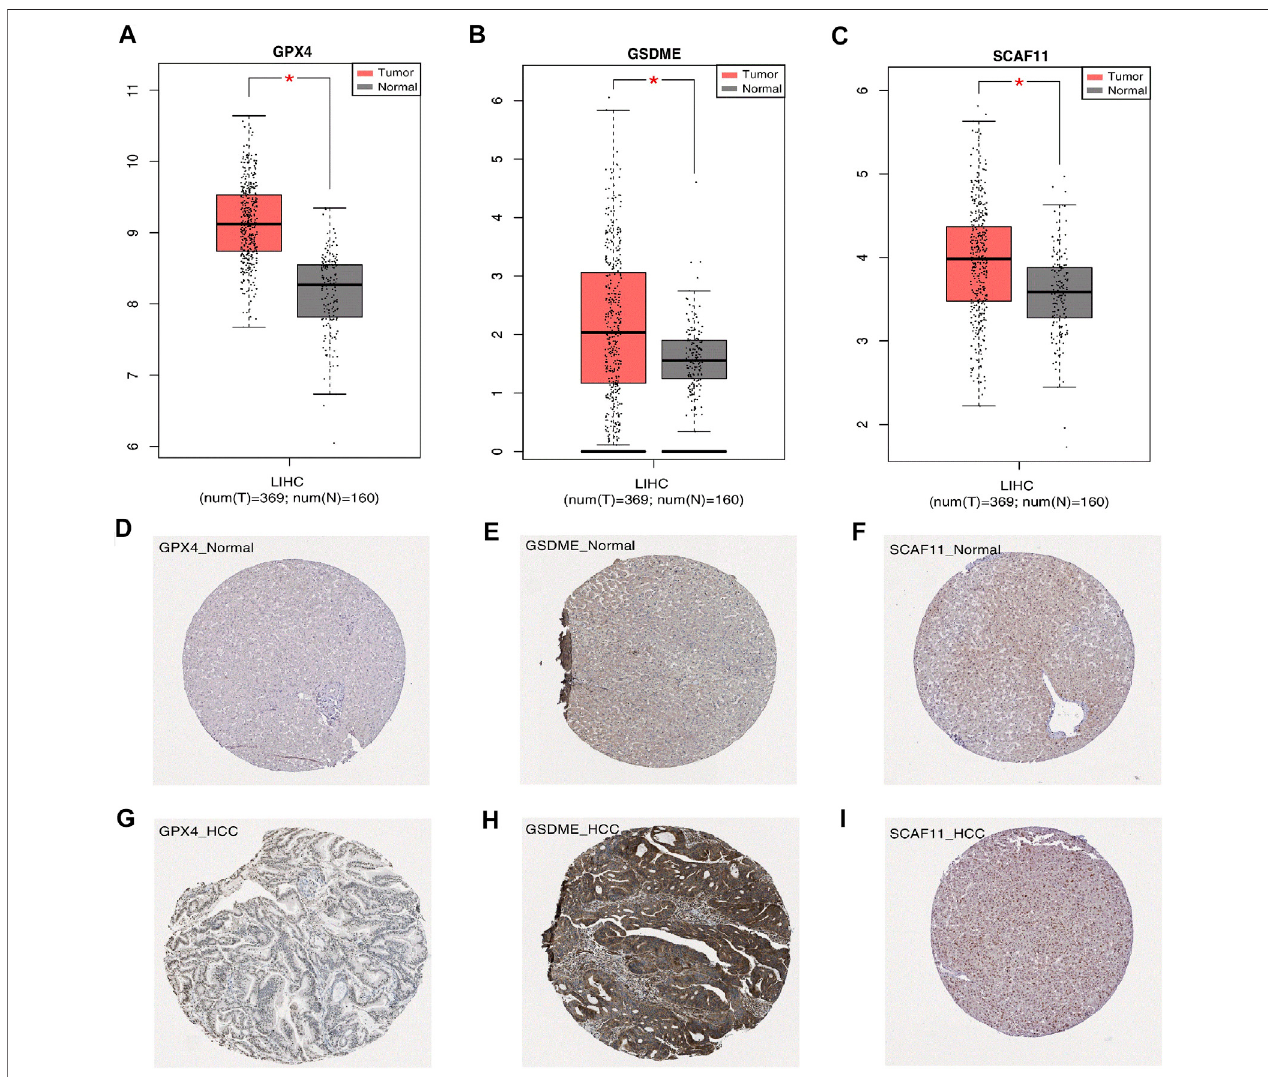
FIGURE9| Expressionoftheindependentprognosticgenes. (A – C) ThegenemRNAexpressionsofGPX4,GSDME,SCAF11inthenormalandtumorgroups(* p < 0.05). (D – I) Immunohistochemistry of the GPX4, GSDME, SCAF11 in the normal and tumor groups from the HPA database.